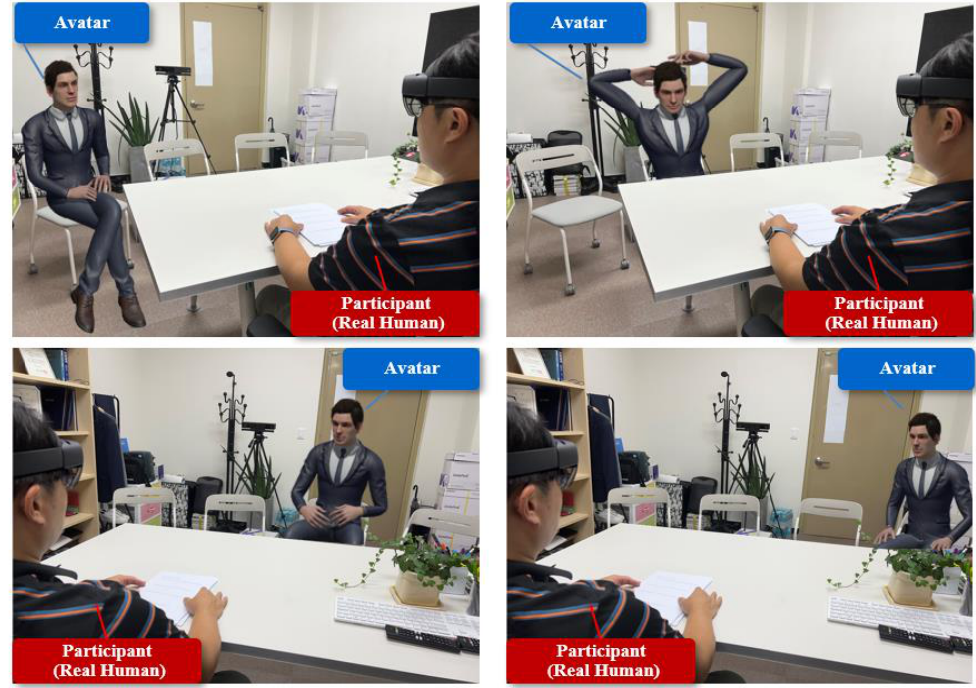
Figure 6. The results of the MR avatar’s gaze adjusted with the participant’s position. The participant’s position was found by the installed depth camera in the local environment. Except for the gaze motion of the avatar, animation of the avatar was played using motion datasets.